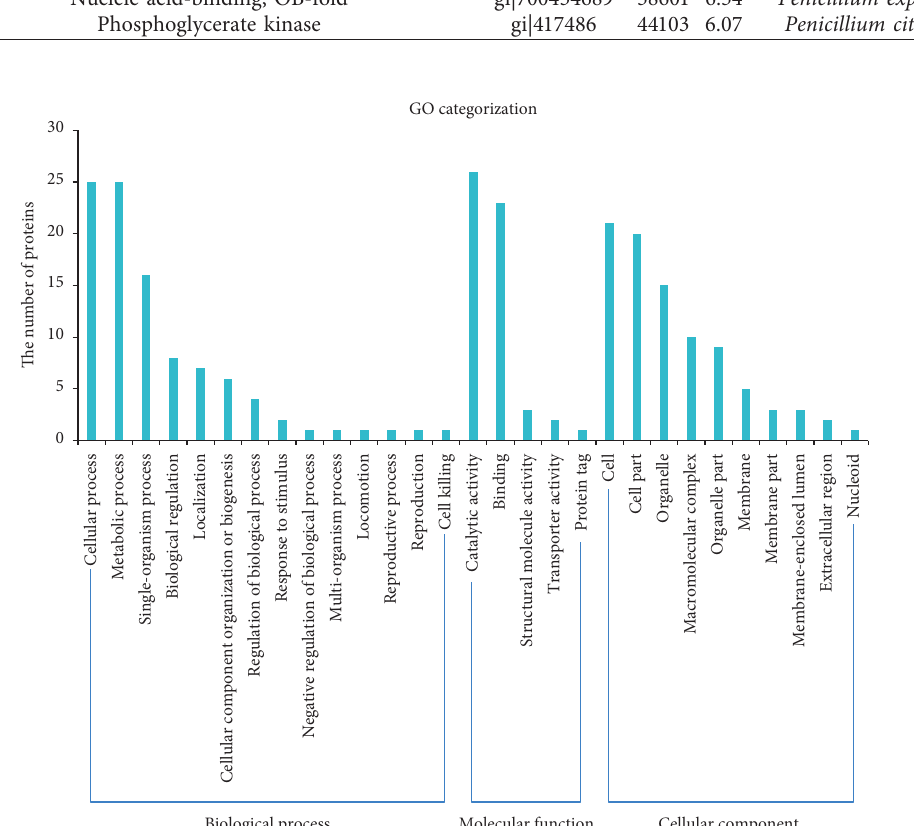
Figure 2: GO categorization of differentially expressed proteins in P. expansum after different treatments. The proteins were categorized according to the annotation of GO, and the number of each category is displayed based on biological process, molecular functions, and cellular